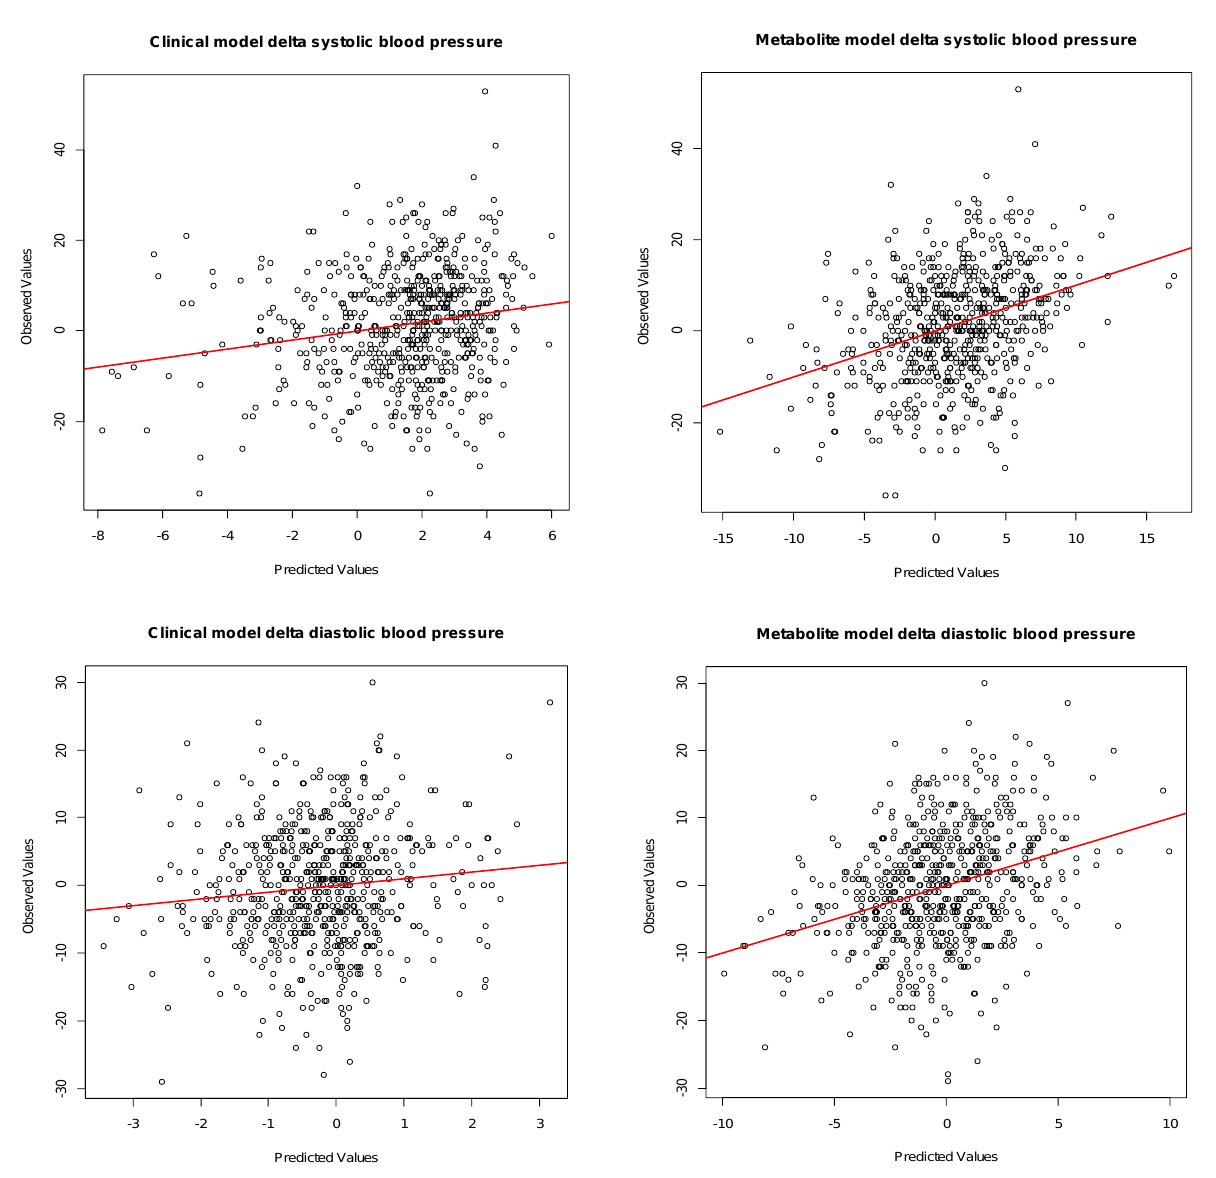
Figure 3. Observed versus predicted values for the linear regression models on diastolic and systolic blood pressure change from first to third trimester. Scatterplot represents observed and predicted values for changes in systolic and diastolic blood pressure from first to third trimester. Predicted values were obtained from linear regression models. Clinical models include maternal age, pre- pregnancy BMI, parity and smoking. Metabolite model includes maternal age, pre-pregnancy BMI, parity, smoking, and arginine, asparagine, glycine, lysine, tryptophan, NEFA_18_0, NEFA_26_0, PC.aa.C34.4, PC.ae.C36.5, SM.a.C37.1, SM.a.C38.2, SM.a.C39.2, SM.a.C41.1, SM.a.C43.2, Carn.a.C16.1, Carn.a.C16.2 and asparagine/aspartic acid